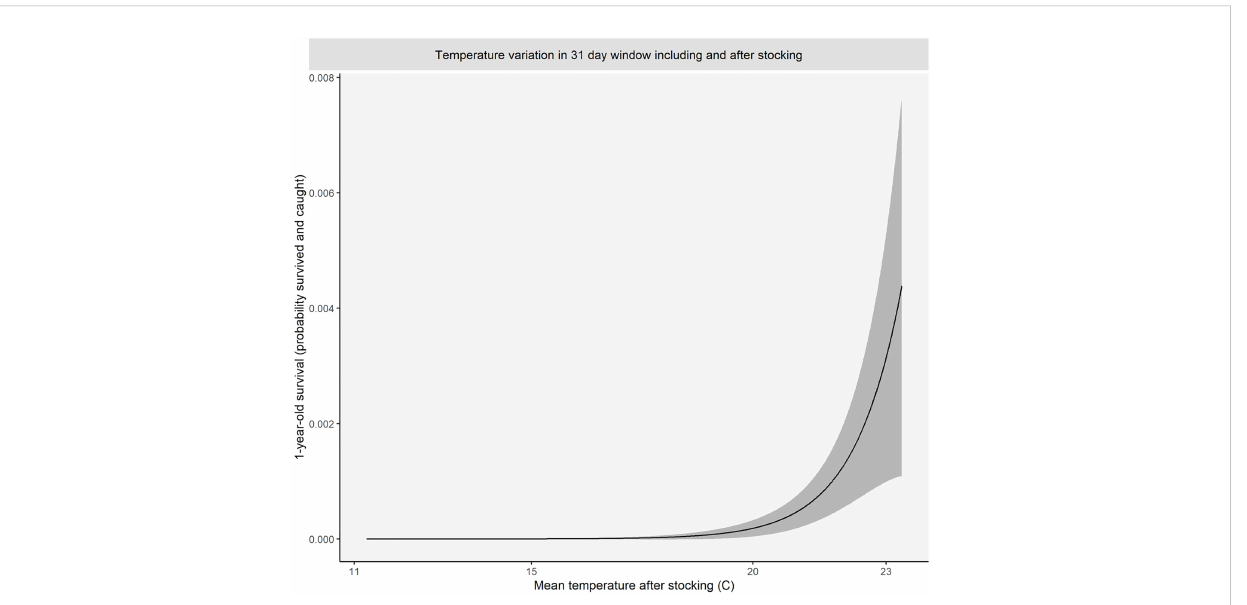
FIGURE 6 Predicted survival of fi ngerlings to age 1+ based under varying water temperatures in the 31 days following release in summer (based on average fi shing